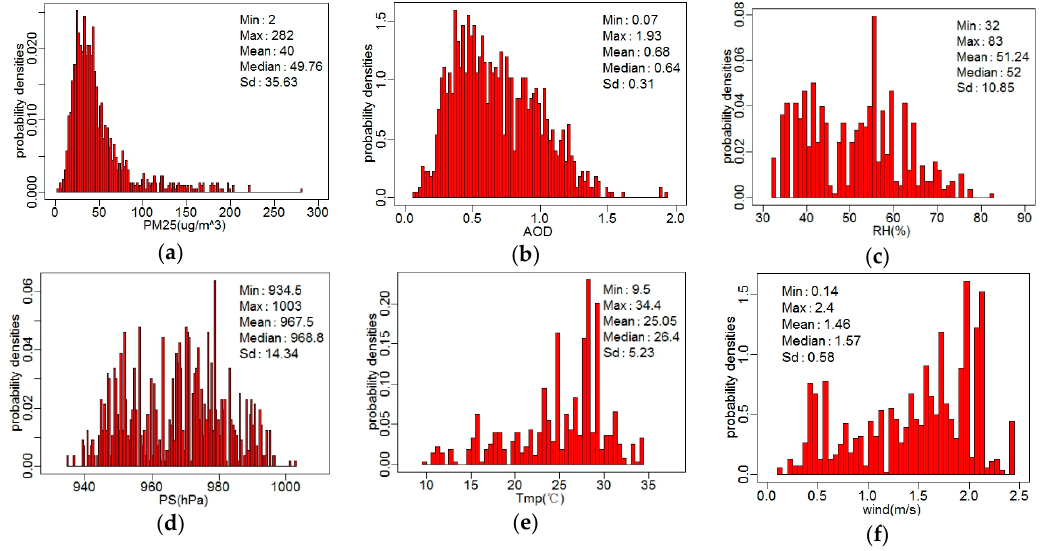
Figure 5. Histograms and descriptive statistics of all dependent and independent variables included in the model fitting data set (N = 1106). ( a ) fine particulate matter (PM 2.5 ); ( b ) aerosol optical depth (AOD); ( c ) relative humidity (RH); ( d ) surface pressure (PS); ( e ) urface temperature (Tmp); ( f ) wind speed (wind).